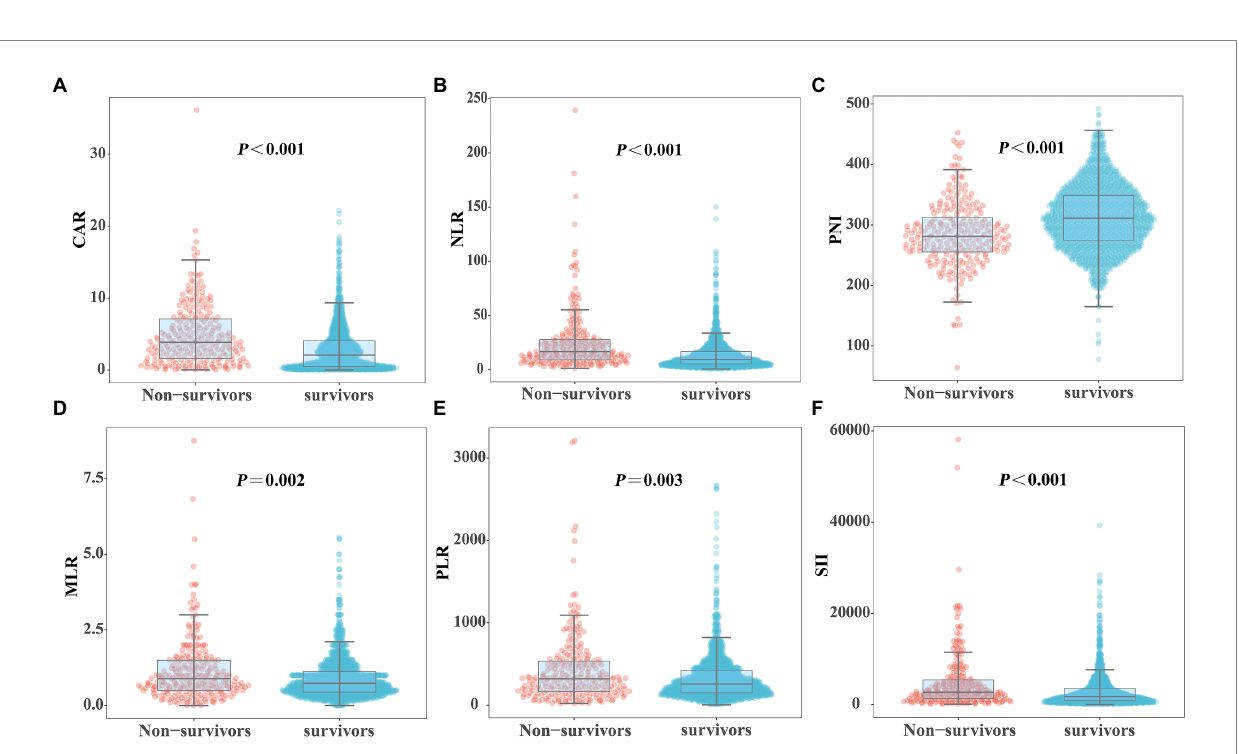
FIGURE 3 Comparison of novel serological biomarkers between survivors and non-survivors groups. (A) CAR, (B) NLR, (C) PNI, (D) MLR, (E) PLR, (F) SII. Data were presented as medians (IQR). Statistical significance was calculated by Mann–Whitney U test. p values indicated differences between patients in non- survivors and survivors